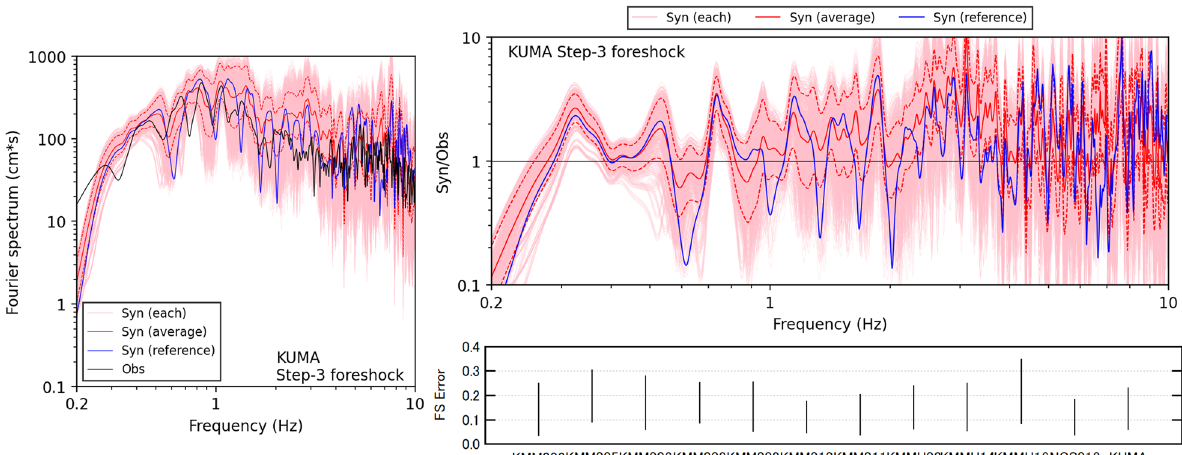
Fig. 10 Variation of the predicted Fourier spectrum at KUMA for the foreshock. (Left) Pink lines indicate the synthetic Fourier spectra of cases that showed better average FS errors than the reference case. The red line indicates the geometric mean of pink lines. The blue line indicates the synthetic Fourier spectrum of the reference case. The black line indicates the observed Fourier spectrum. (Upper right) Pink, red, and blue lines indicate the spectral ratios of the lines of same type in the left panel to the observed spectrum. (Bottom right) Black lines indicate the ranges of FS error at each site